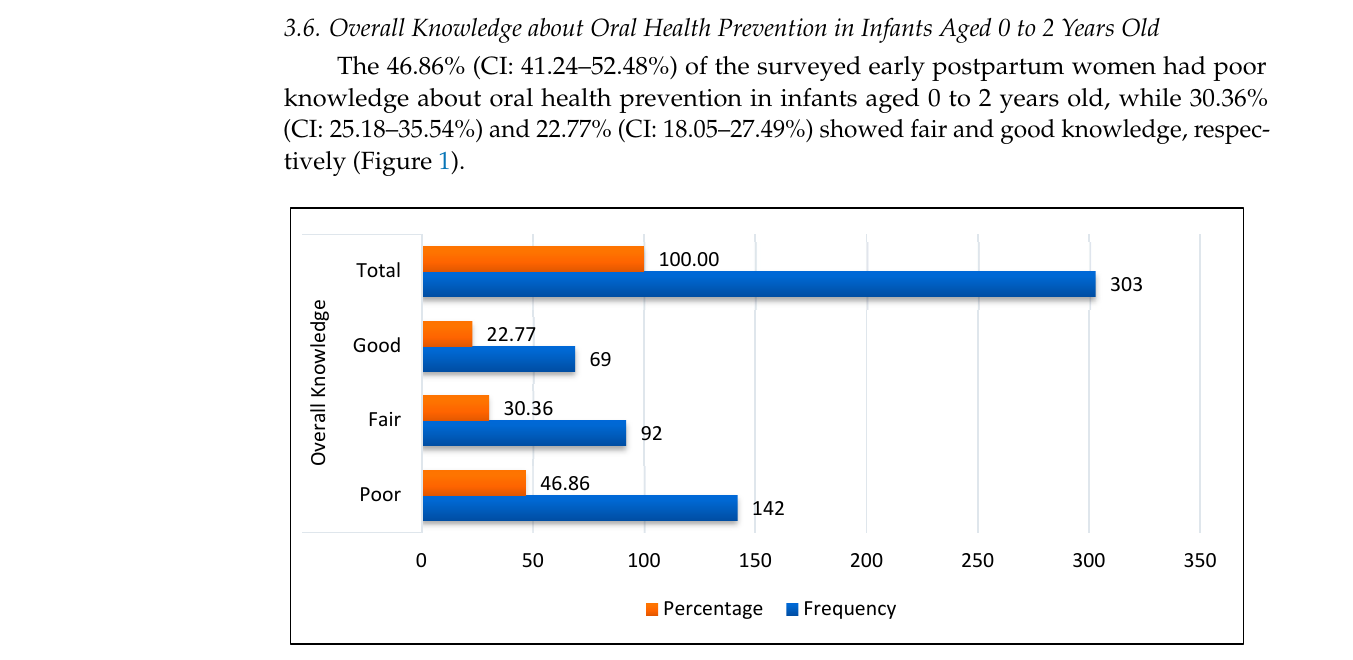
Figure 1. Frequency of early postpartum women’s overall knowledge about oral health prevention in infants aged 0 to 2 years old.